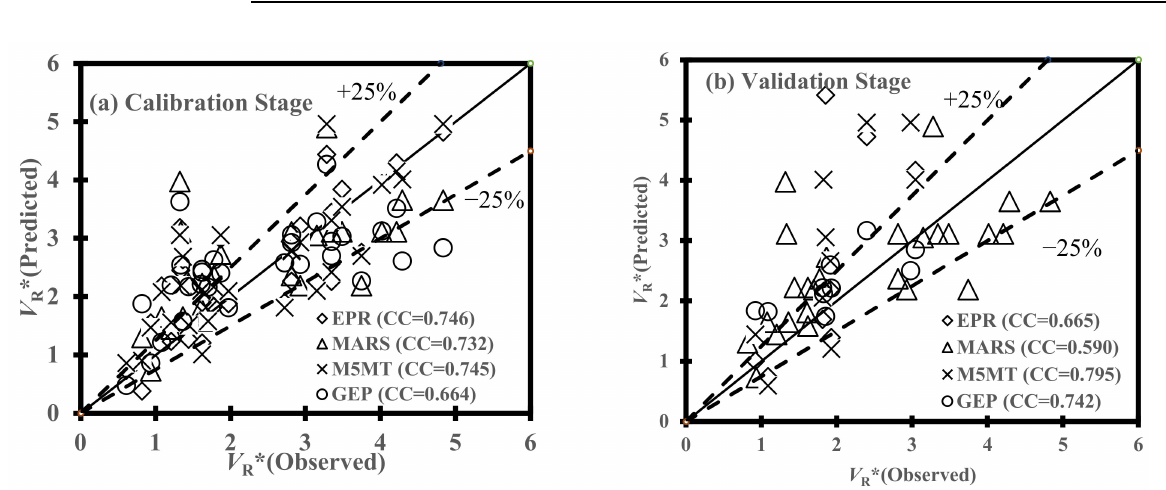
Figure 4. Performance of soft computing models in the prediction of V R * for ( a ) calibration and ( b ) validation